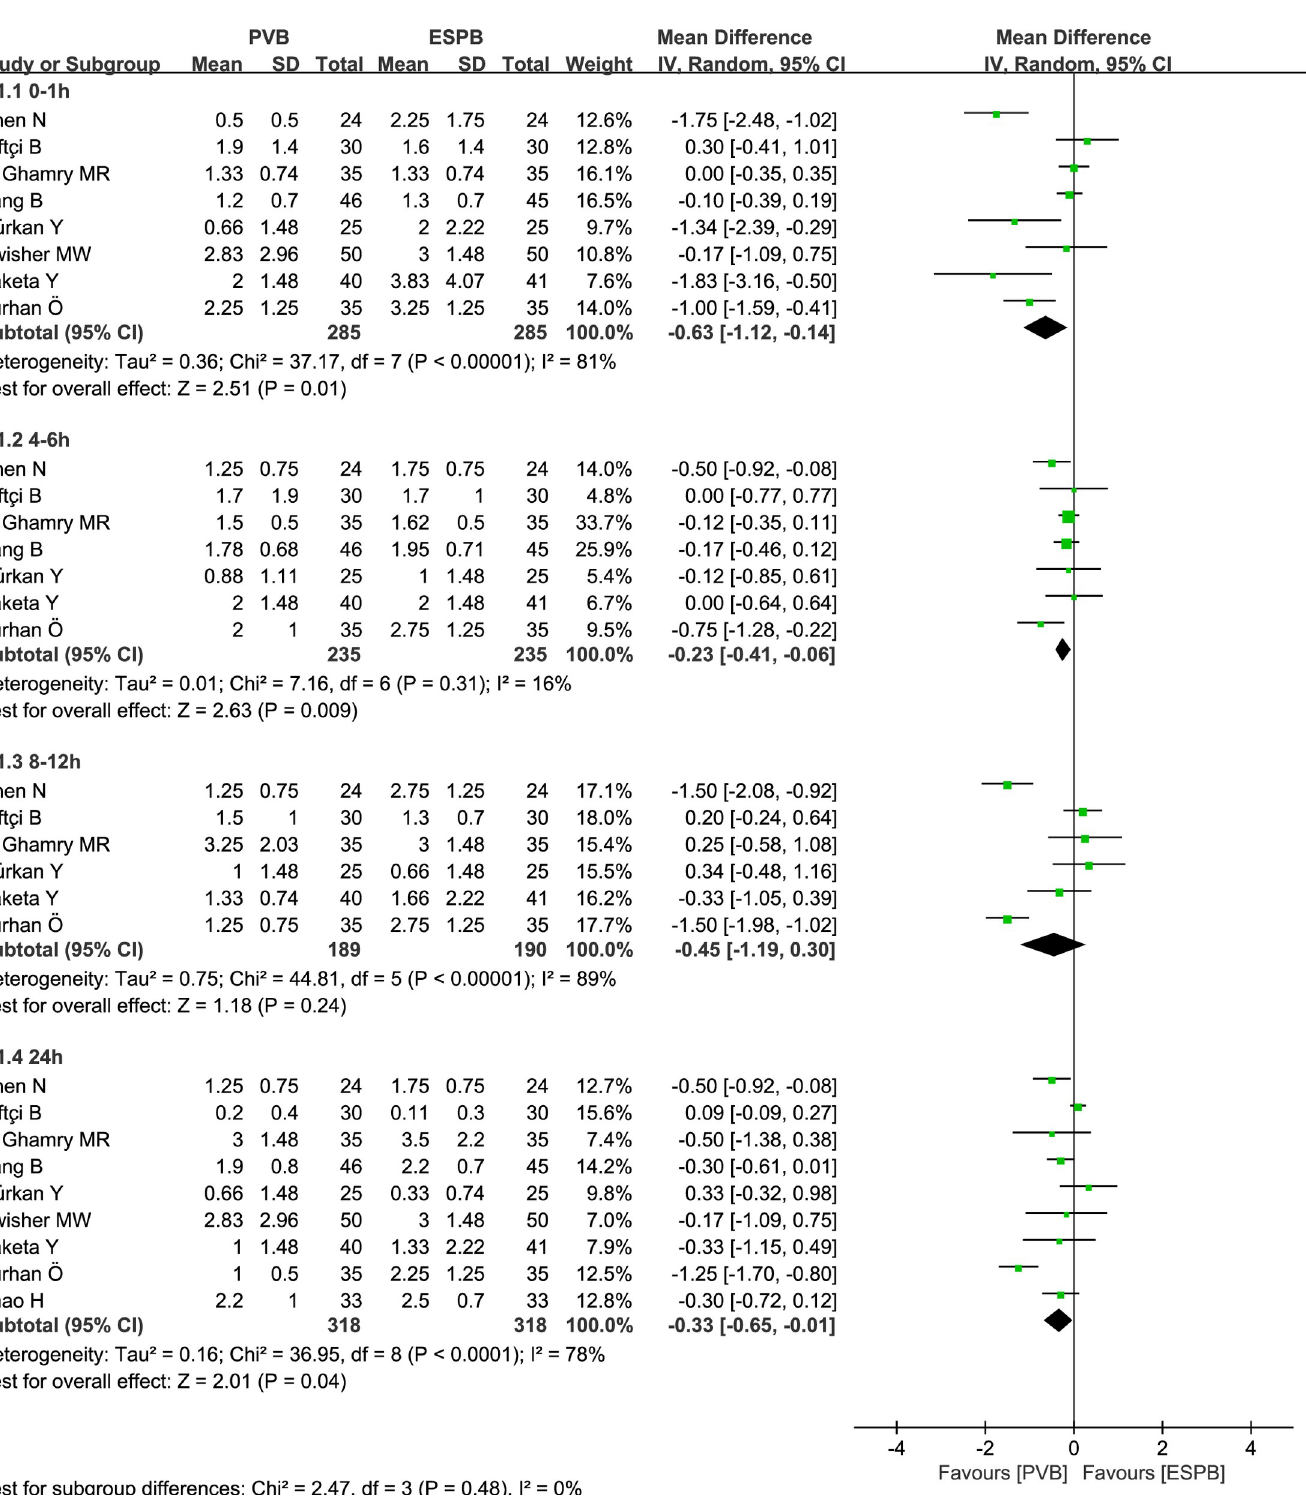
Fig 3. Forest plot of postoperative scores for resting pain at 0–1, 4–6, 8–12, and 24 hours.